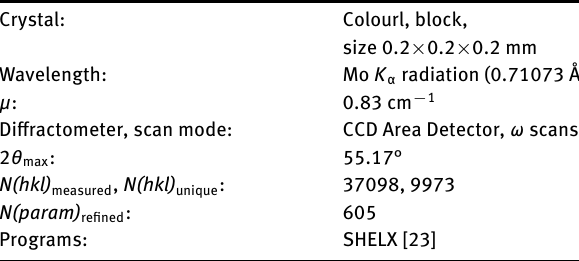
Table 1: Data collection and